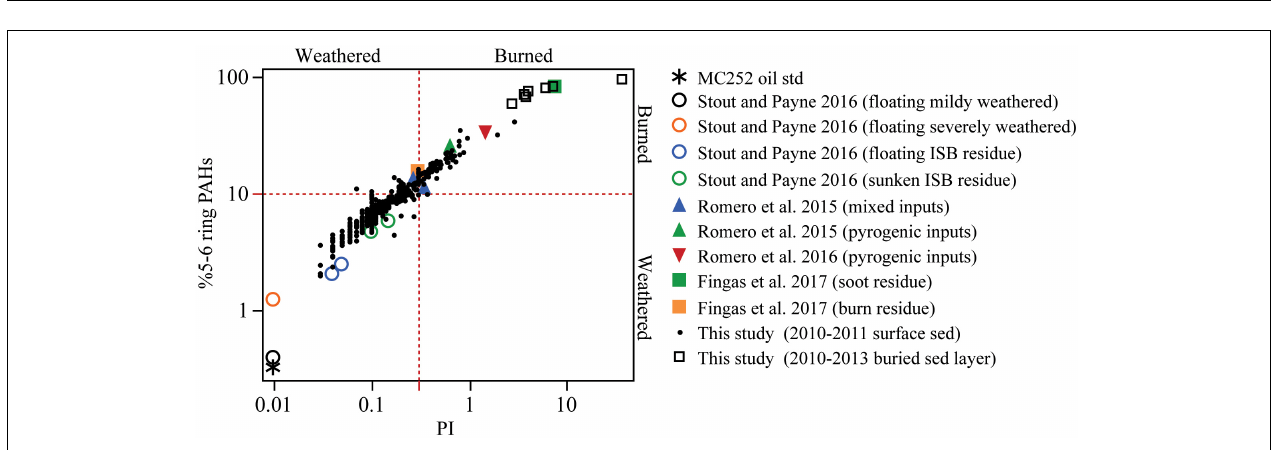
FIGURE 7 | Correlation between PAH ratios for samples analyzed in this study (low %LMW content in contaminated sediments collected in 2010–2011 and 2018) and from previous studies in the nGoM ( R = 0.68, P < 0.001, N = 416). Both x -axis and y -axis shown in logarithmic scale (log base 10).